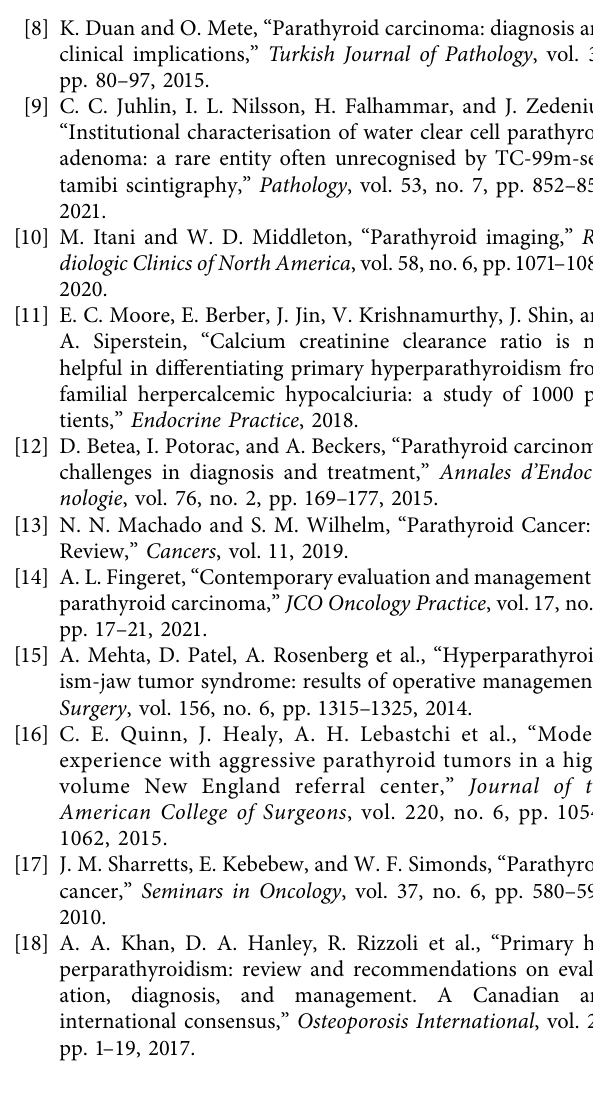
Figure 2: The ultrasound from the patient with a giant parathyroid adenoma. Transverse grayscale images (a) show a giant parathyroid adenoma with a thick capsule and internal echogenic components (arrow). Transverse color doppler images (b) show minimal detectable internal flow